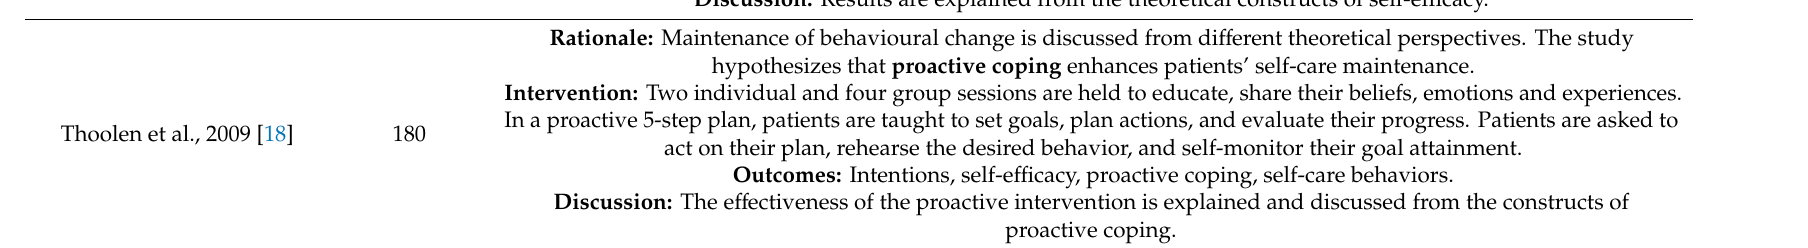
Outcomes: self-e ffi cacy, glycaemic control